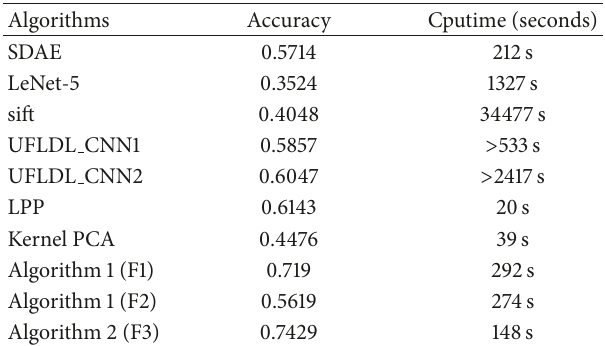
Table 2: The results of comparison experiments on sub Extended Yale B face